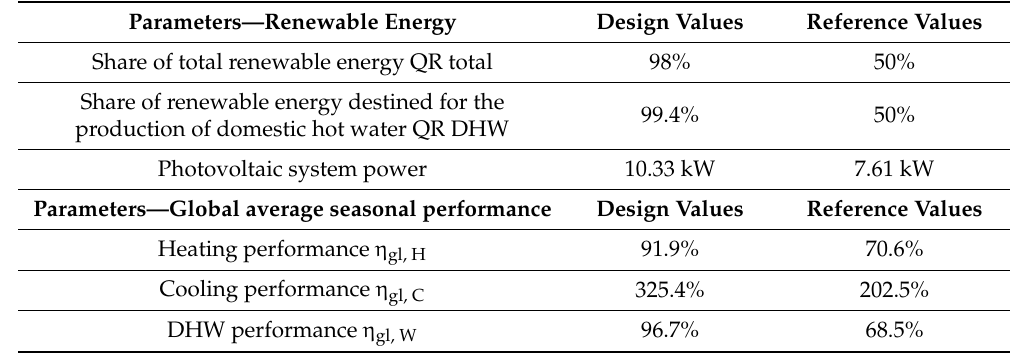
Table 6. E ffi ciency